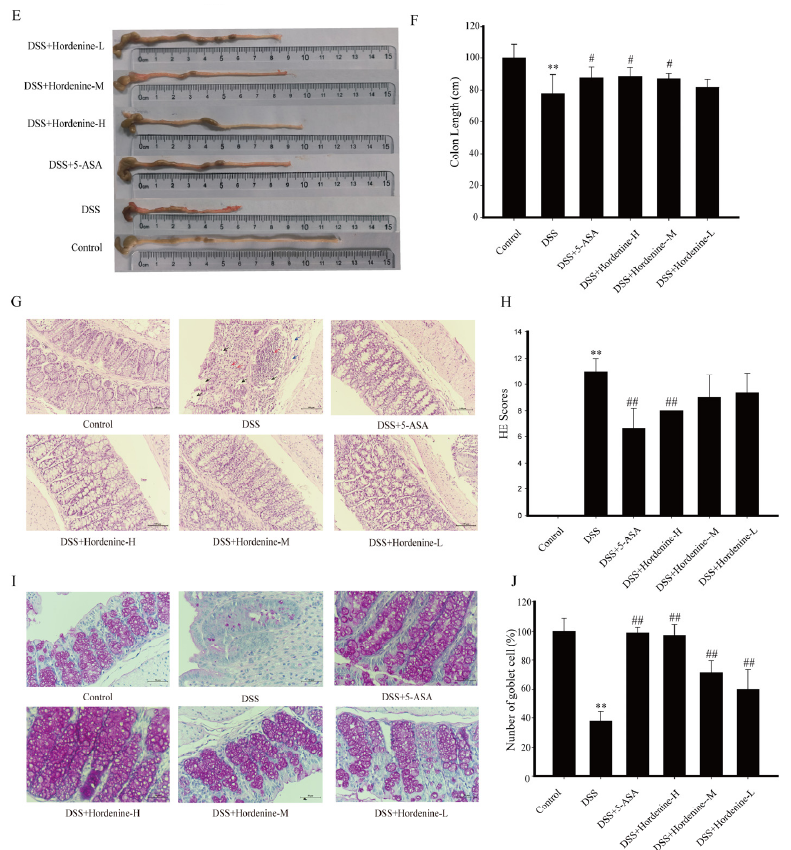
Figure 1. Hordenine ameliorated DSS-induced UC in mice. ( A ) The chemical structure of hordenine. ( B ) Flow chart of the experimental design. SPSS, as known as stroke-physiological saline solution; ELISA: enzyme linked immunosorbent; HE: hematoxylin-eosin staining; IHC: immunohistochemistry; WB: western blot; PAS: periodic acid-Schiff (PAS) staining; the elements in the graph are derived from figdrow. ( C ) Changes in body weight. ** p < 0.01 vs. control group; # p < 0.05, ## p < 0.01 vs. DSS group. ( D ) The DAI scores were calculated. ( E ) The macroscopic representations of colons. ( F ) The colon lengths among the six groups. ** p < 0.01 vs. control group; # p < 0.01 vs. DSS group. ( G ) Hematoxylin and eosin staining of colonic sections. Ulcer and necrosis are indicated by black arrow. Inflammatory cell infiltration and aggregation are indicated by red arrow. Tissue edema is indicated by blue arrow. Scale bar: 100 µ m. ( H ) Histological changes. ** p < 0.05 compared with control group; ## p < 0.05 compared with DSS group. ( I ) periodic acid-Schiff staining of colonic sections. ( J ) Goblet cells count. ** p < 0.05 compared with control group; ## p < 0.05 compared with DSS